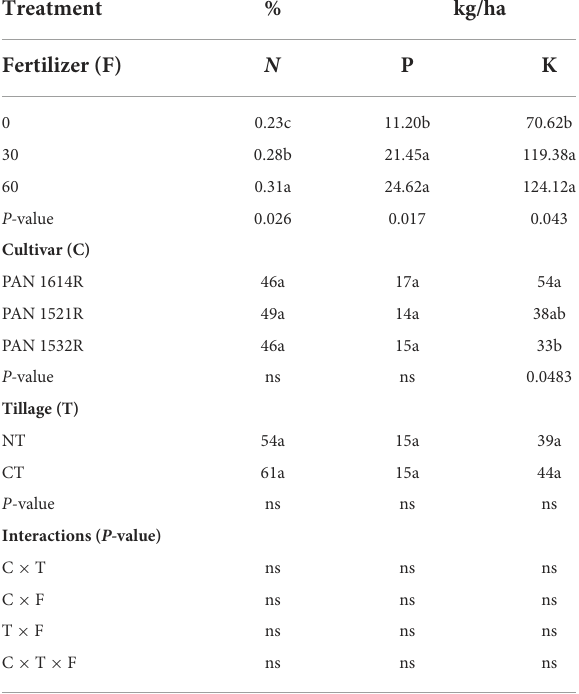
TABLE 4 Effects of fertilizer, cultivar and tillage on plant nutrient uptake on a soybean cropping system. Treatment